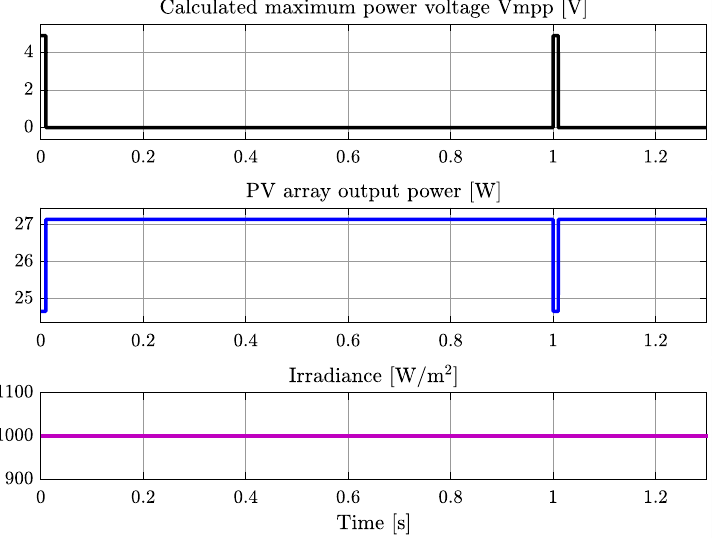
Figure 10. Scenario 1: Sunny day with constant